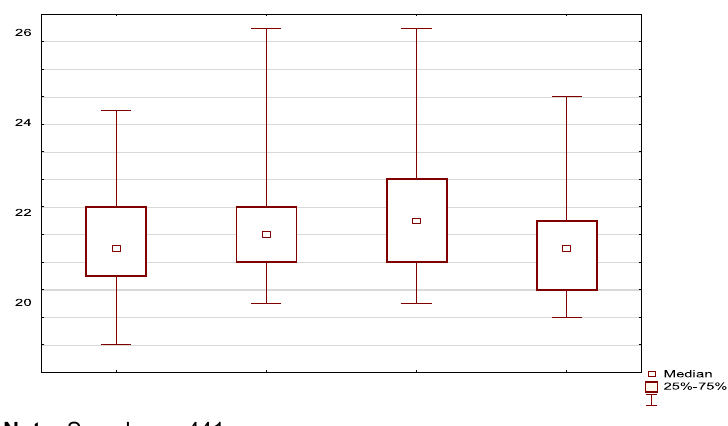
Table 8. Post-hoc tests for violence